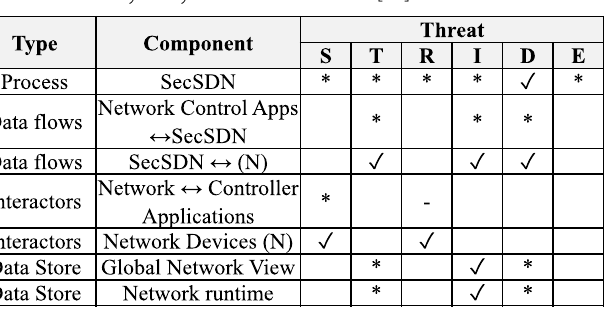
Table 14 Security analysis of SecSDN-Cloud